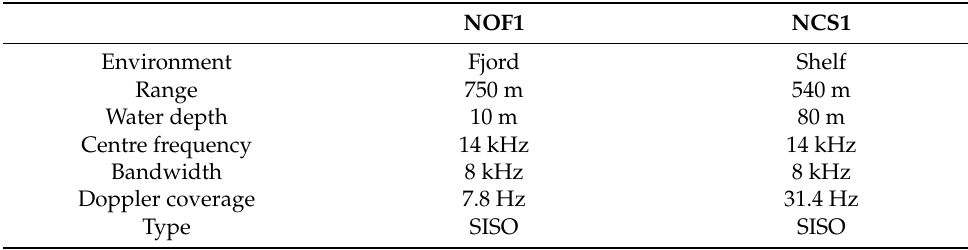
Table 2. Parameters of the Watermark channels and the signal [44].